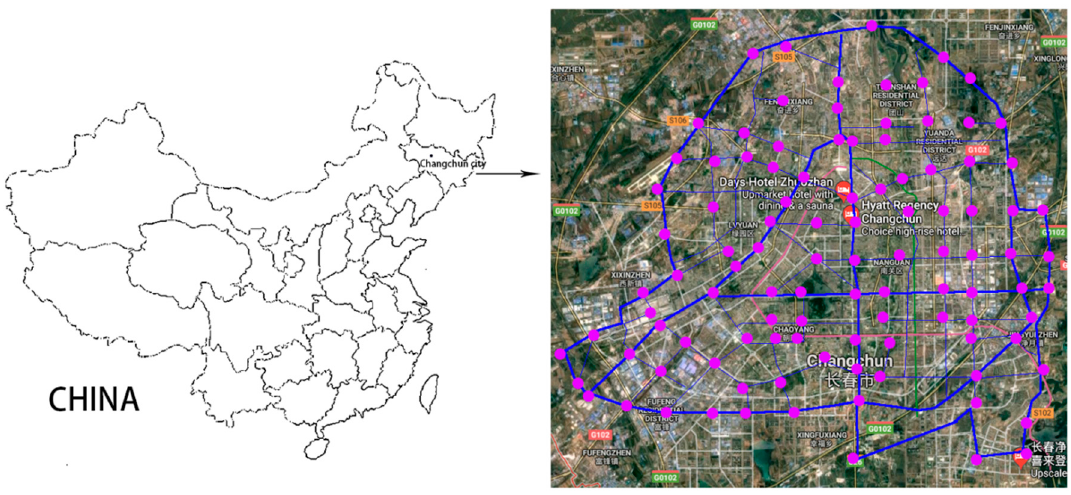
Figure 1. Sampling sites.